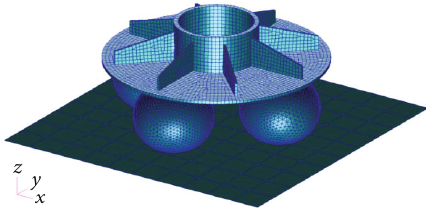
Table 2: Mechanical characteristics of the